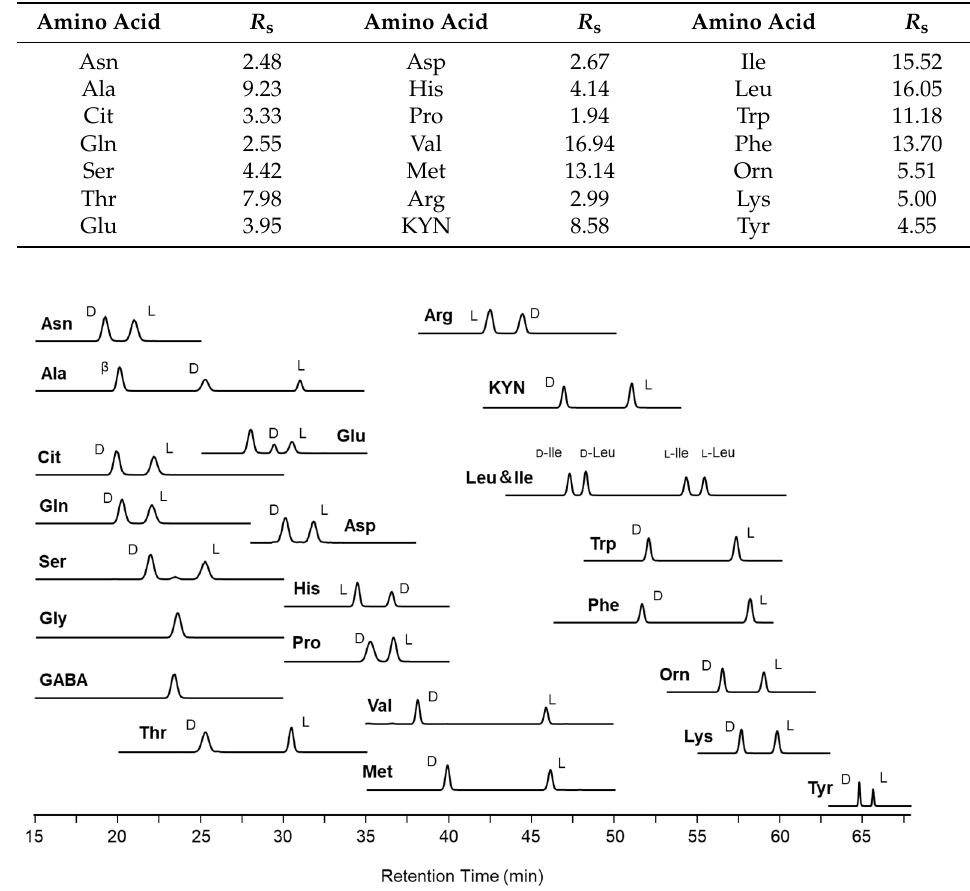
Figure 1. Representative chromatograms of mixed standard D - and L -amino acid samples obtained using the mixed-phase column. The mobile phase conditions are described in the text, Section 3.4.